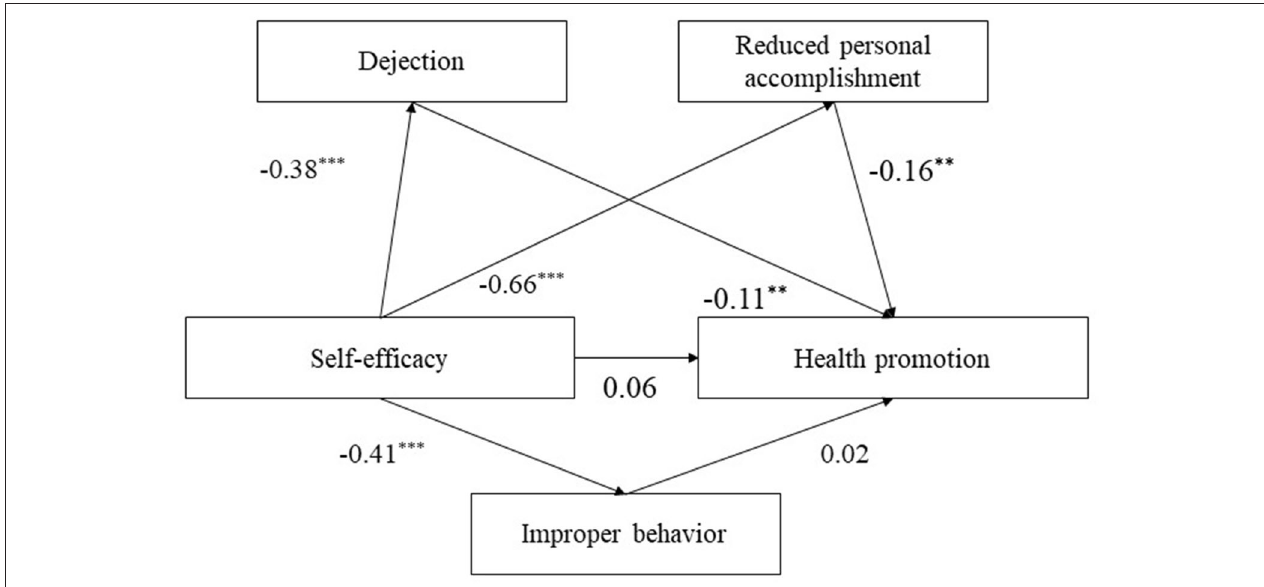
FIGURE 4 | The structural model of self-efficacy, dejection, and reduced personal accomplishment on health promotion. Significant paths are presented by asterisks (** p < 0.01, *** p <